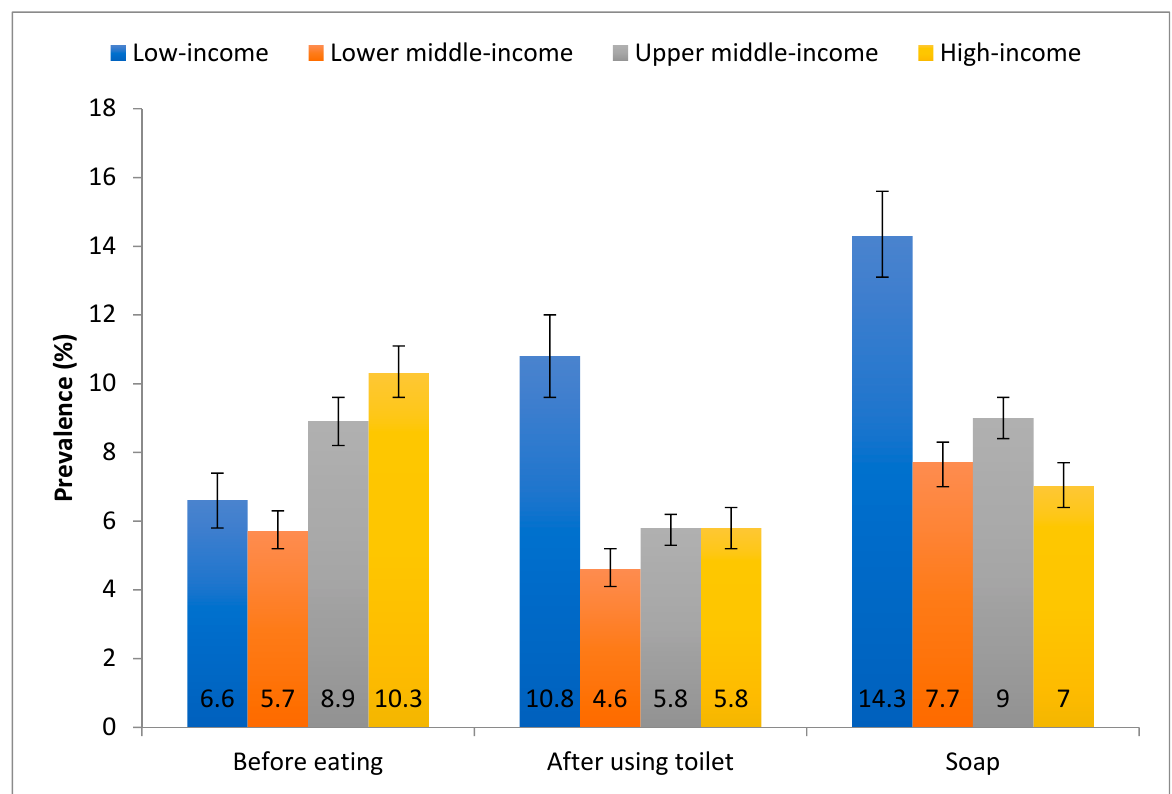
Figure 2. Prevalence of never/rarely washing hands before eating, after using toilet, and with soap by country-income level. Bars denote 95% confidence interval. Table 3. Association between severe food insecurity and never/rarely washing hands before eating, after using toilet, and with soap estimated by meta-analysis with random effects based on country-wise estimates. Outcome Country-Income